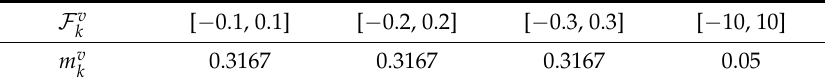
Table 1 Evidence of state noise.